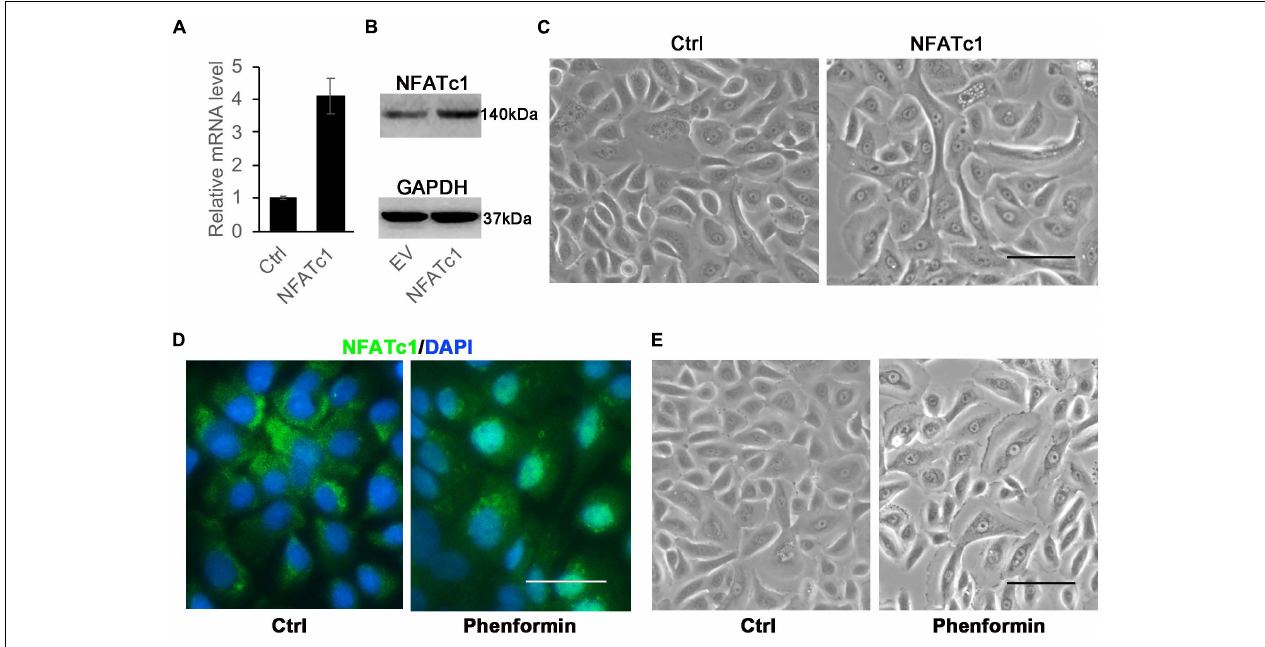
FIGURE 5 | Activation of NFATc1 doesn’t significantly induce vacuole formation in human keratinocytes . (A,B) Human keratinocytes were infected with a NFATc1 expressing or a control retrovirus, and 24 h after infection, the cells were collected for analysis of NFATc1 expression by RT-PCR (A) or by immunoblotting (B) . GAPDH as a loading control in panel (B). The experiments were carried out three times, and error bars represent means ± SD; p values are indicated with “*,” ** p < 0.01, when comparing with the control group by Student’s t -test in panel (A) . (C) Representative images of human keratinocytes infected with a NFATc1 expressing or a control retrovirus for 24 h. (D,E) Human keratinocytes were treated with 1 mM phenformin for 24 h, then were fixed and analyzed NFATc1 (green) expression by immunofluorescence staining, DAPI stained for nuclei (blue). Representative images of human keratinocytes are shown in panel (E). (C–E) Bars = 50